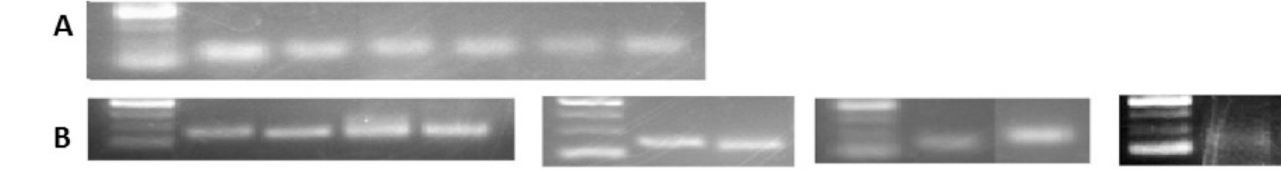
Fig 7. Validation of detected known and predicted novel miRNAs by PCR. From left to right the samples are as follows: (A) Known miRNAs 1) DNA marker, 2) miR166b, 3) miR166m, 4) miR393, 5) miR395, 6) miR156, 7) miR399. (B) Novel miRNAs (nmiR) 1) DNA marker, 2) nmiR2, 3) nmiR5, 4) nmiR6, 5) nmiR9, 6) DNA marker, 7) nmiR3, 8) nmiR4, 9) DNA marker, 10) nmiR1, 11) nmiR7, 12) DNA marker, 13) nmiR8. The DNA marker is O’range Ruler 50bp ThermoFisher with the range of 50 to 200 with 50bp increments.